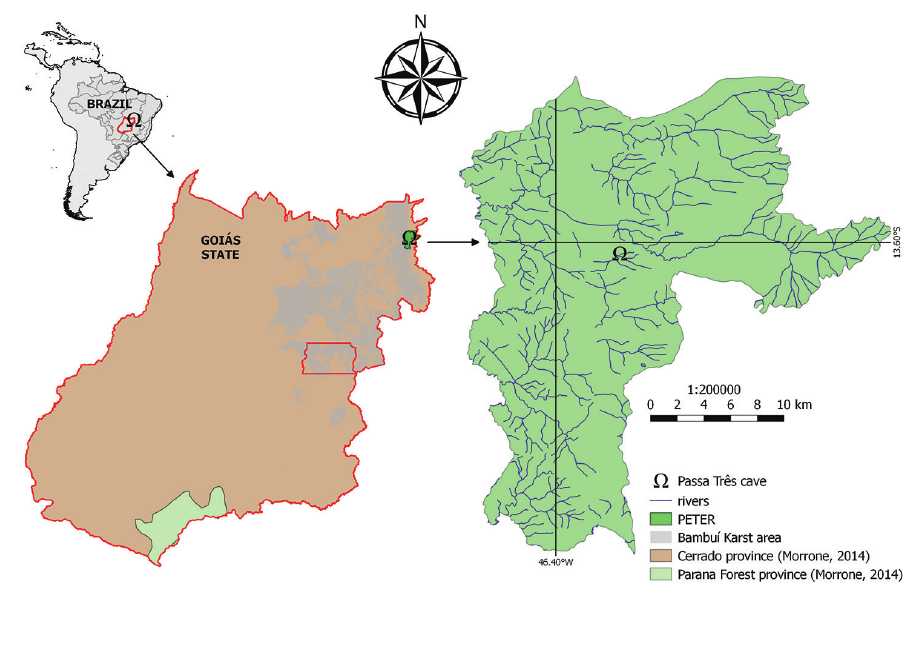
Figure 1. Study area, showing the limits of PETeR (Parque Estadual de Terra Ronca), northeastern state of Goiás, central Brazil. (Map organized in QGIS software, version 2.18, Author: Diego M. von